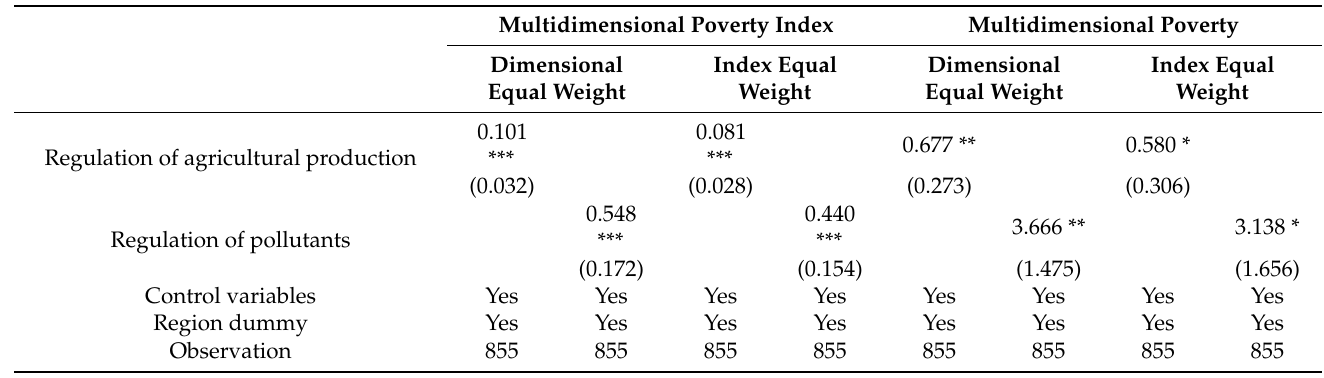
Table 9. Different types of regulation and the multidimensional poverty of farmers ( k = 3).